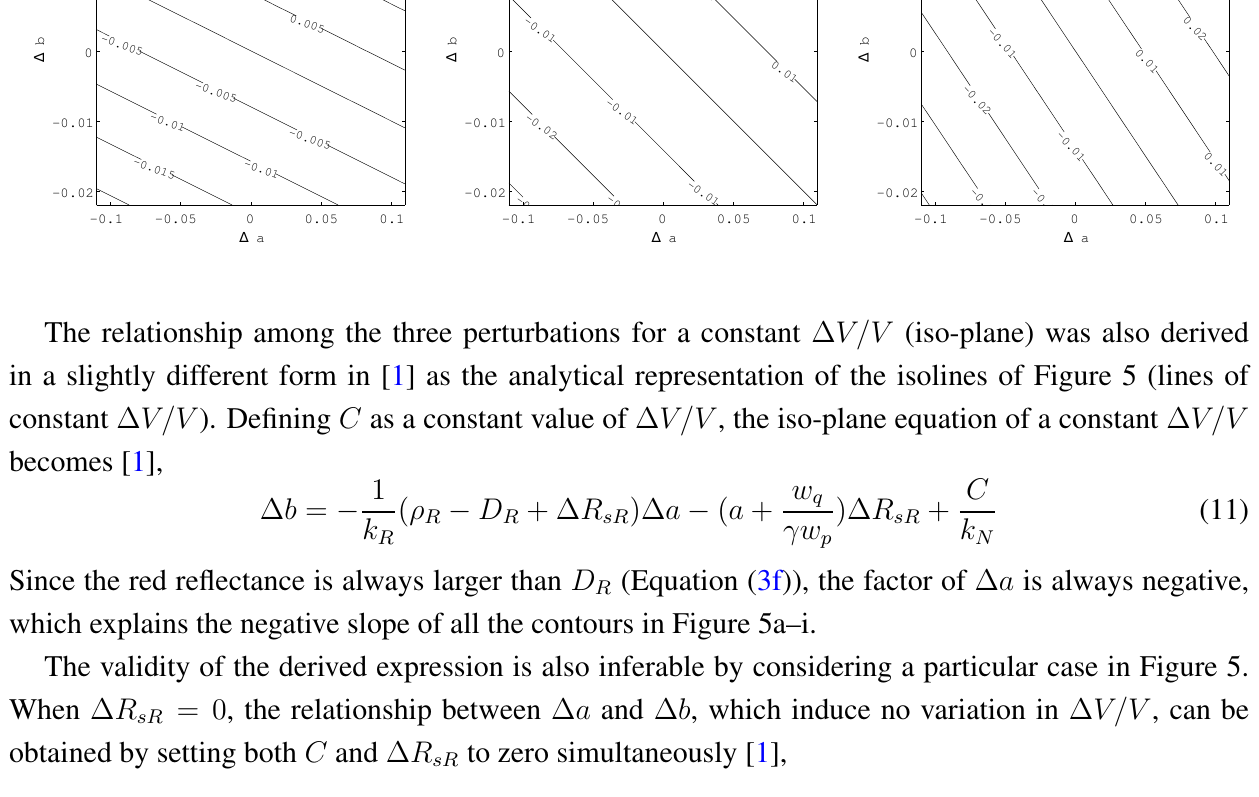
Figure 7. ∆ V=V for the three R